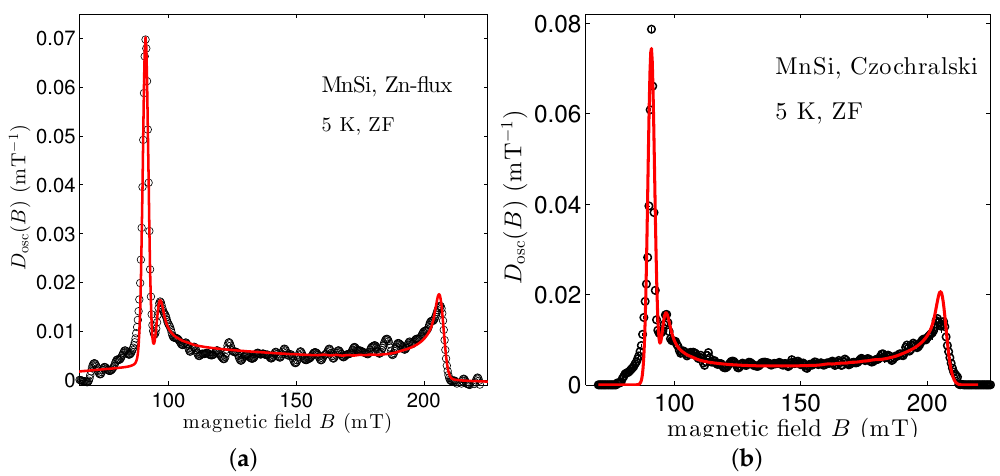
Figure 3. Comparison of the field distributions measured by zero-field muon spin rotation ( µ SR) experiments on Zn-flux grown ( a ) and Czochralski ( b ) crystals of MnSi. The circles correspond to a model-free treatment of the data according to a Maximum-Entropy supplemented reverse Monte Carlo algorithm. The uncertainties (one standard deviation) computed with this treatment are also shown: it occurs that the error bars are smaller or equivalent to the point sizes. The solid lines result from fits to the raw asymmetry spectra, i.e., they are not fits to D osc ( B ) , as explained in the main text. Note that the distribution displayed in ( b ) is not obtained with the same method as that in [9], which resulted from a Fourier transform of the raw spectrum. Because of the high statistic of the spectrum and the absence of strong damping, the results are similar. It is not always the case [20]. Table 1. The free parameters related to the magnetic structure required to describe the µ SR spectra. The rows correspond to the parameters defined in the main text and their values with uncertainties for the two samples, respectively. The parameters for the Czochralski crystal are taken from